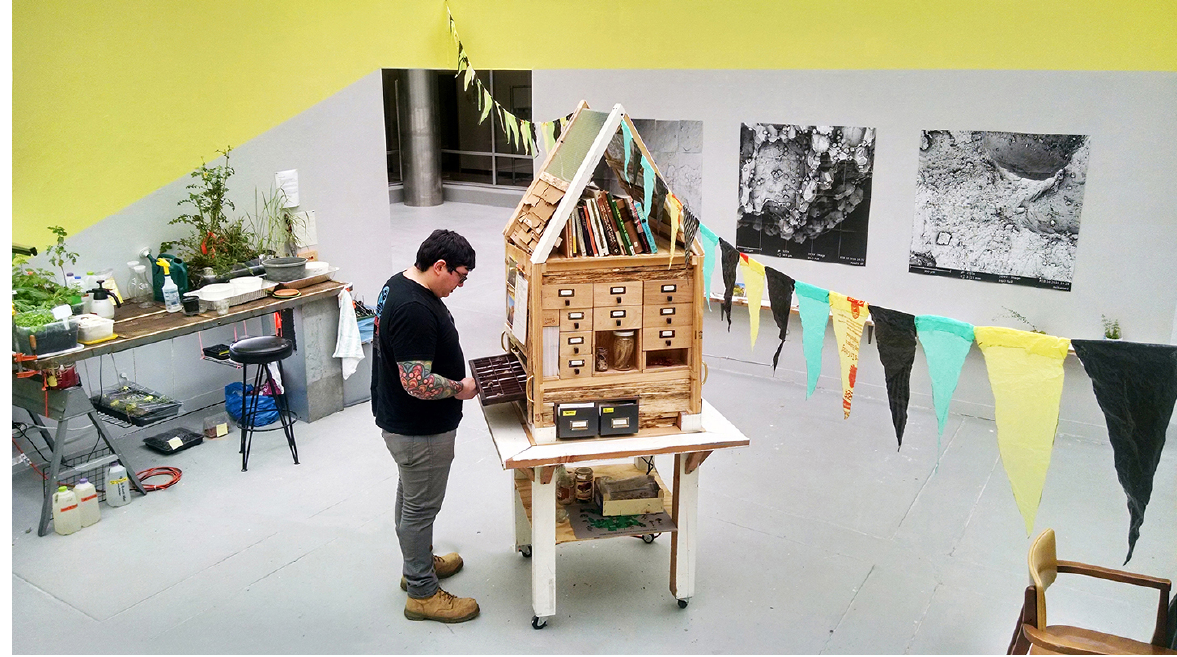
Figure 2: The Next Epoch Seed Library at William Paterson University in spring 2016 for the exhibition Nurturing Nature . This functioning, participatory library installation included a central structure housing our seed collection available for checkout, books and curriculum guides, video documentation, plant propagation and seed sorting stations, a reading area with community bulletin board, and enlarged microscopy photos of seeds in our collection. Visible here are the seed collection structure, microscopy photos, and plot propagation station. Photograph courtesy of Anne Percoco, Next Epoch Seed